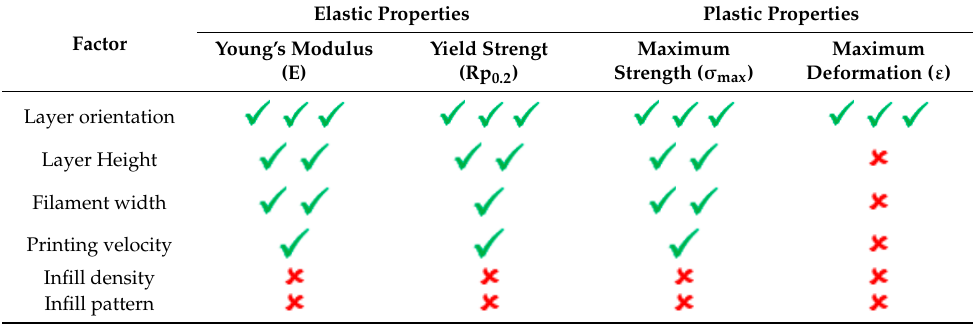
Table 7, the optimum levels of each parameter are shown. Table 6. Significance value of the parameters with respect to the answers. Table 6. Significance value of the parameters with respect to the answers. Table 6. Significance value of the parameters with respect to the answers. Table 6. Significance value of the parameters with respect to the answers. Table 6. Significance value of the parameters with respect to the answers. Table 6. Significance value of the parameters with respect to the answers. Table 6. Significance value of the parameters with respect to the answers. Table 6. Significance value of the parameters with respect to the answers. Table 6. Significance value of the parameters with respect to the answers. Table 6. Significance value of the parameters with respect to the answers. Table 6. Significance value of the parameters with respect to the answers. Table 6. Significance value of the parameters with respect to the answers. Table 6. Significance value of the parameters with respect to the answers. Table 6. Significance value of the parameters with respect to the answers. Table 6. Significance value of the parameters with respect to the answers. Table 6. Significance value of the parameters with respect to the answers. Table 6. Significance value of the parameters with respect to the answers. Table 6. Significance value of the parameters with respect to the answers. Table 6. Significance value of the parameters with respect to the answers. Table 6. Significance value of the parameters with respect to the answers. Table 6. Significance value of the parameters with respect to the answers. Table 6. Significance value of the parameters with respect to the answers. Table 6. Significance value of the parameters with respect to the answers. Table 6. Significance value of the parameters with respect to the answers. Table 6. Significance value of the parameters with respect to the answers.